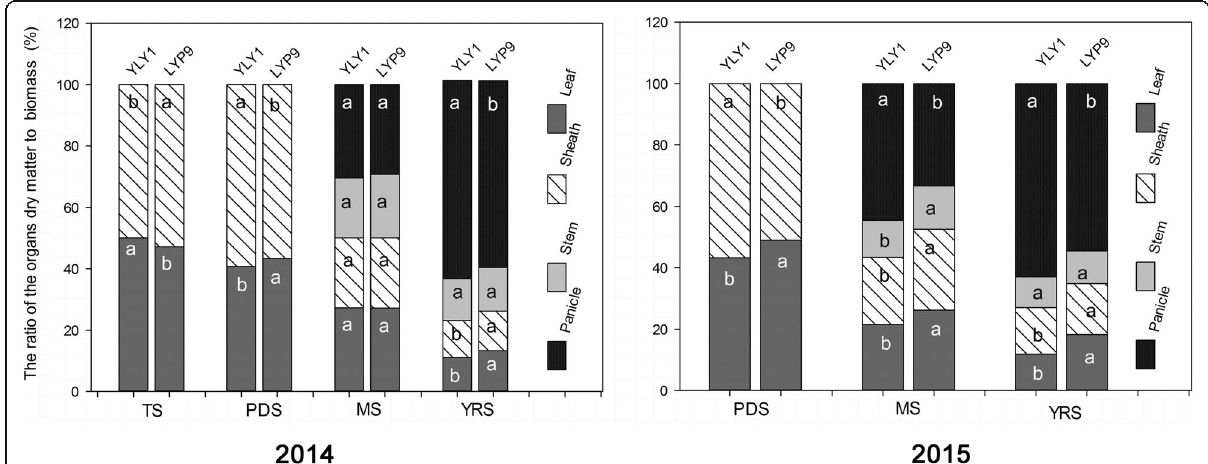
Fig. 7 The biomass composition at different developmental stages in 2014 and 2015. The ratios of biomass in four different tissues, including leaf, sheath, stem and panicle, to total biomass are shown in the figure. Data for four different stages are shown. See definitions of different stages in Fig. 4. The different letter means represent significance levels of p = 0.05